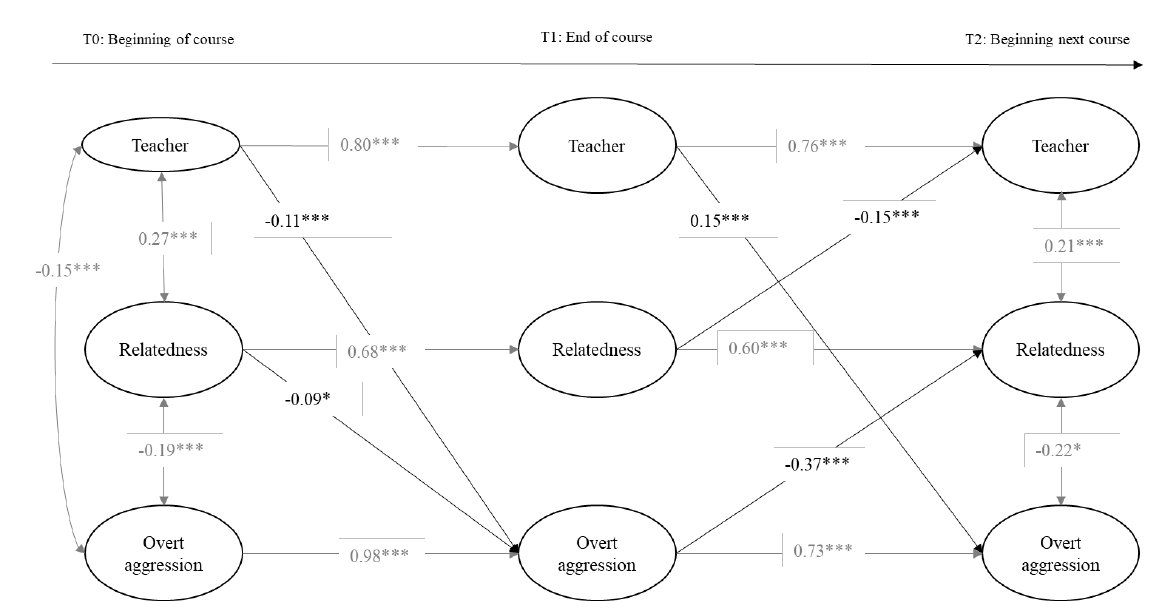
Figure 1. Cross-lagged model predicting longitudinal reciprocal relations between teacher support, relatedness, and overt aggression in girls. Only estimates significant at p < 0.05 or less are provided. Cross-lagged paths are depicted in bold. * p < 0.05; *** p < 0.001.